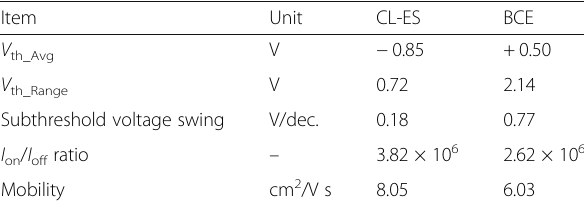
Table 1 Comparison of I-V characteristics of a-IGZO-based TFT device with CL-ES structure and BCE